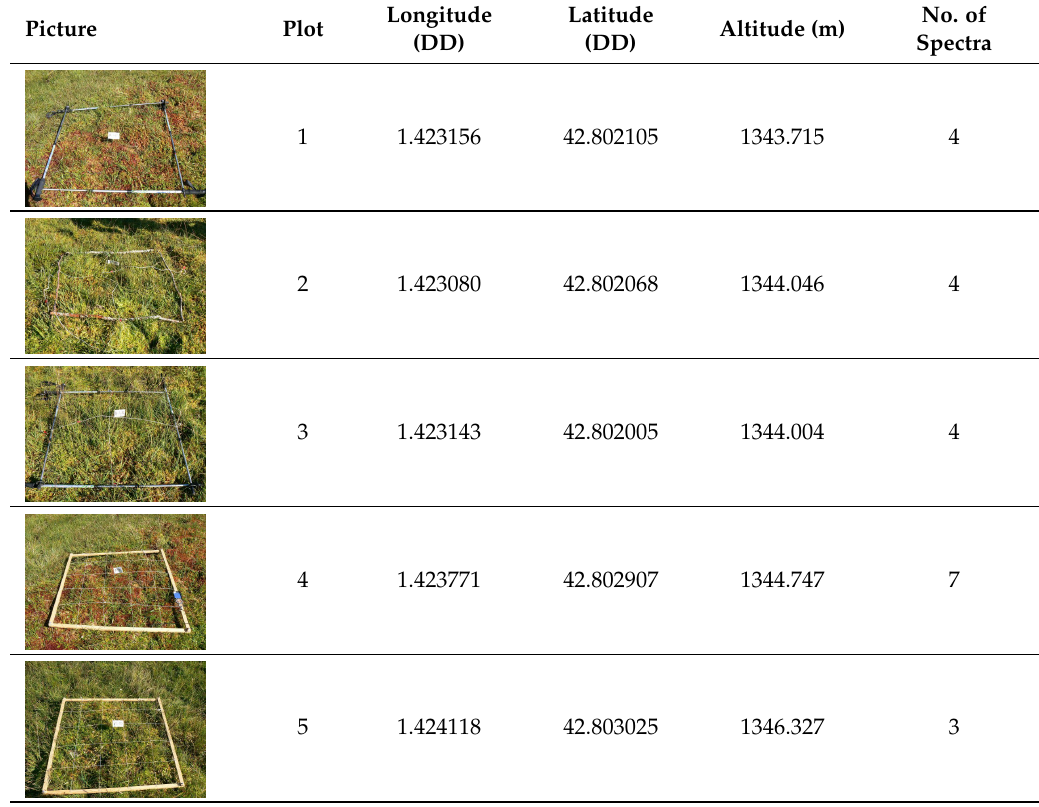
Table A2. Pictures, plots, geographic coordinates and number of spectra of Sphagnum sp. (SPHA). Longitude Picture Plot